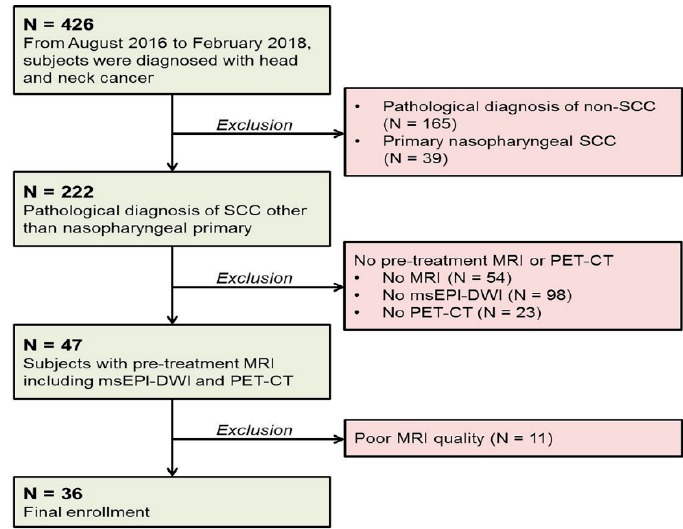
Figure 1. Patient flow diagram. Patients who were diagnosed with head and neck cancer and met the predetermined criteria were included in the final study population. Note—SCC, squamous cell carcinoma; MRI, magnetic resonance imaging; PET-CT, 2-deoxy-2-[fluorine-18]-fluoro-D-glucose ( 18 F-FDG) positron emission tomography-computed tomography; msEPI-DWI, multi-shot echo-planar imaging-based diffusion-weighted imaging.